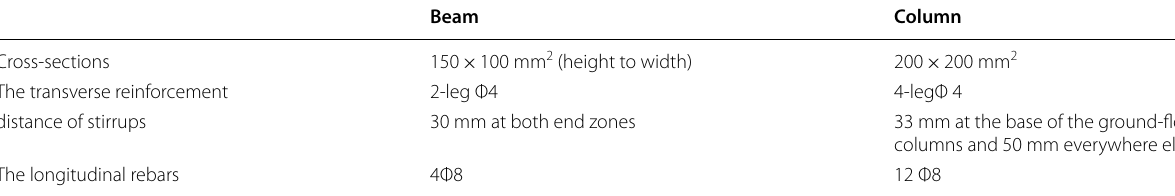
Table 2 The specifications of beams and columns of the test